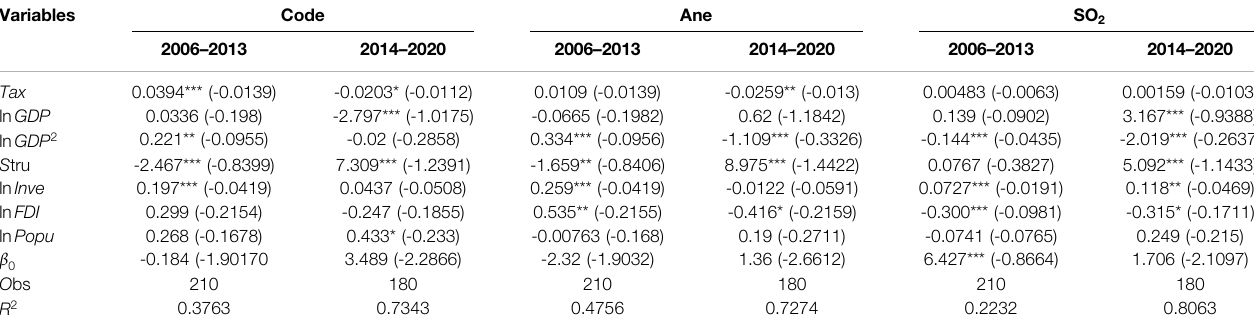
TABLE 4 | Results of environmental taxes and the robustness of emissions of three types of pollutants in 30 provinces and cities in China.